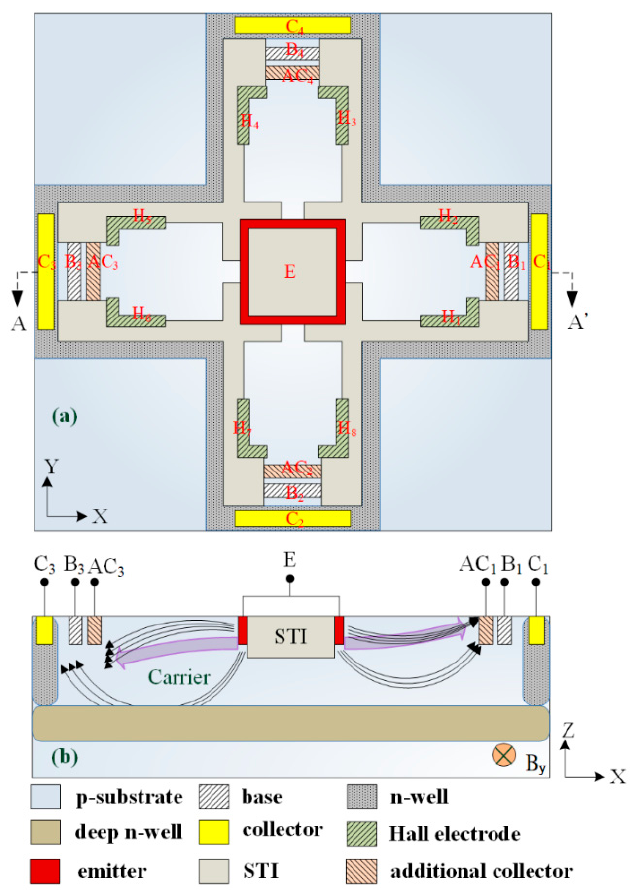
Figure 1. Micro magnetic field (MMF) sensor: ( a ) schematic structure; ( b ) cross ‐ sectional view along line AA’. STI, shallow trench isolation; E, emitter.